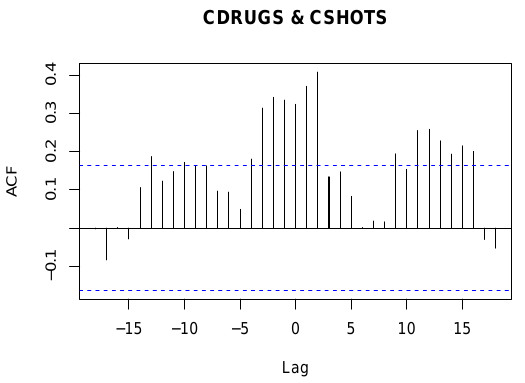
Figure 4. CCF plot of the CDRUGS and CSHOTS datasets. Table 7. Estimates with SEs and CIs, AIC, BIC, and RMSEs of the considered BINAR(1) processes for the crime series